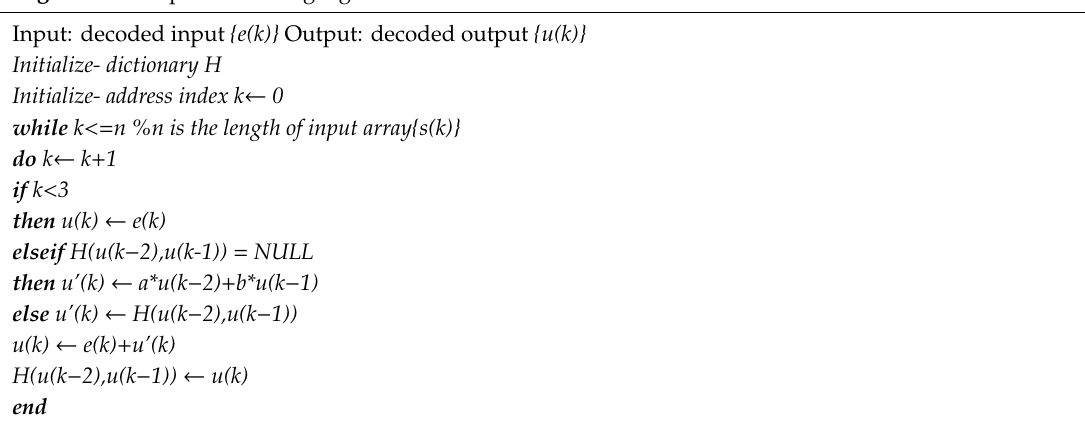
Algorithm 2 steps of decoding